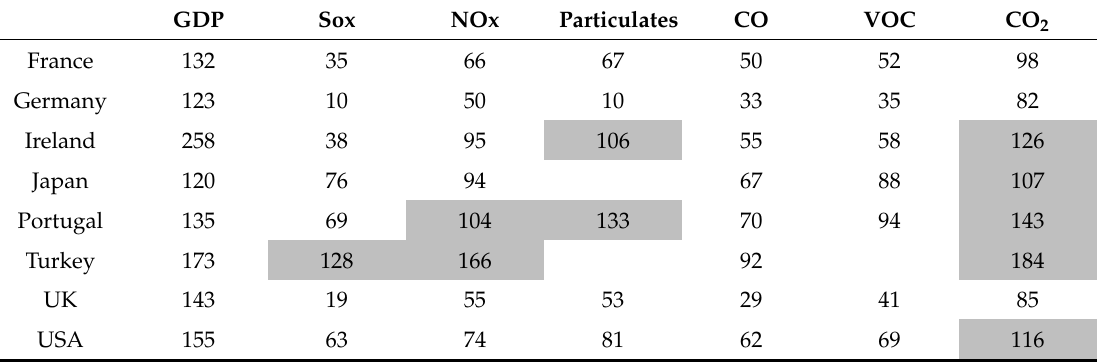
Table 8. GDP and domestically produced emission indices for selected OECD countries. GDP Sox